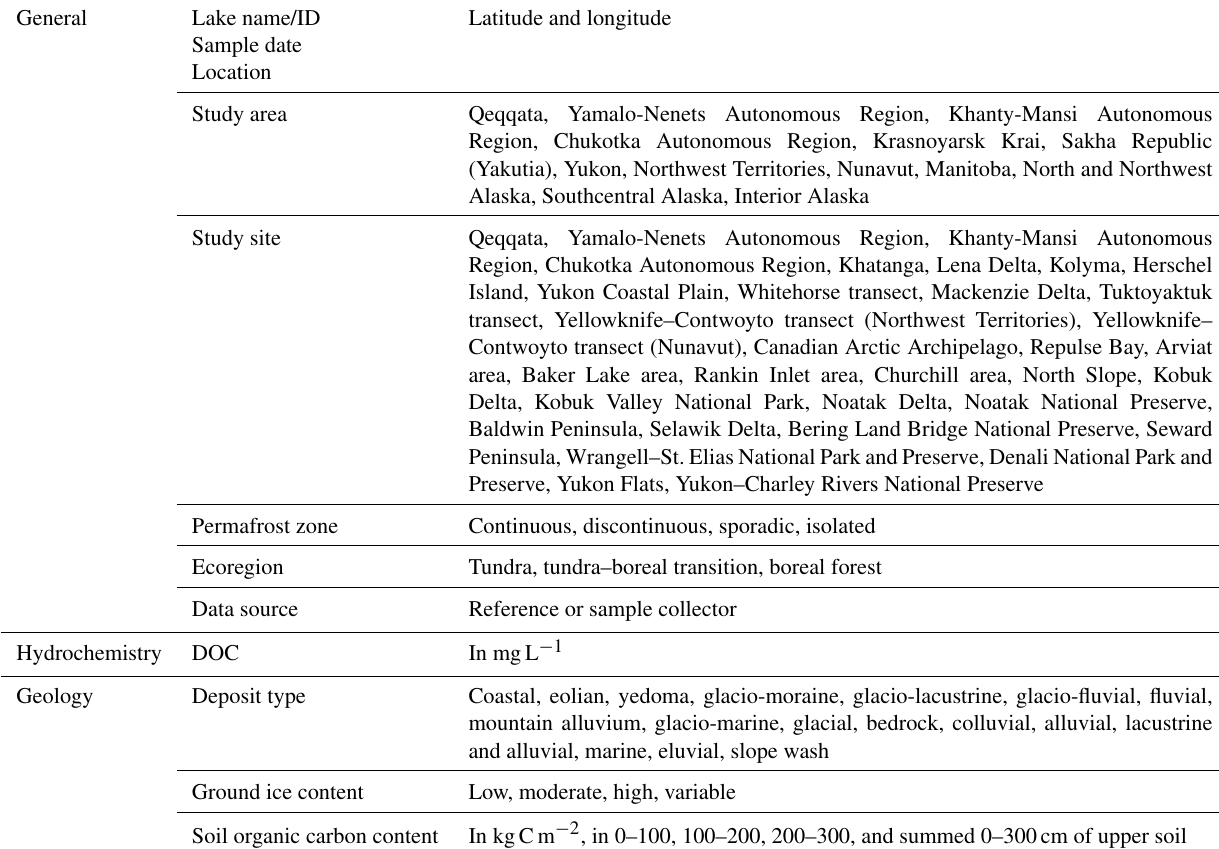
Table A1. Parameters for lake